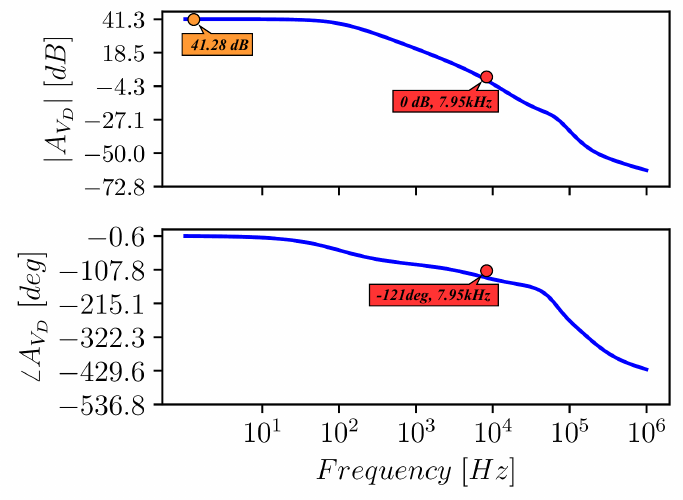
Figure 9. Frequency response of the differential gain (magnitude and phase). The dc common-mode gain is around 6 dB, resulting in a CMRR of about 35 dB; Figure 10 shows the frequency response of the CMRR. Figure 11 reports the input-referred noise spectral density, which shows a white noise level of 1.4 µ V/ √ Hz and a noise corner frequency of about 10 kHz.